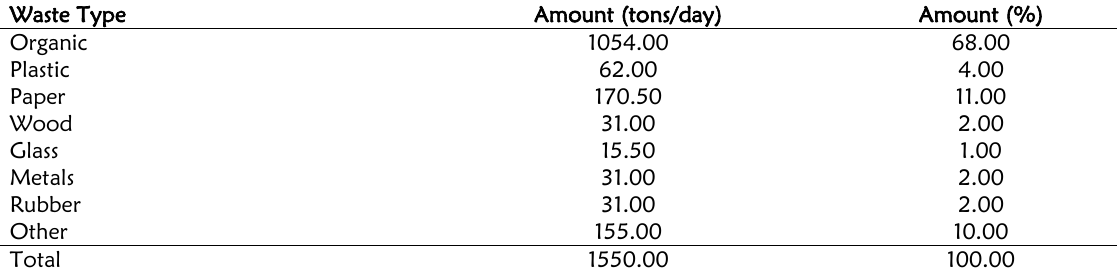
Table 2: Waste composition of Chattogram city